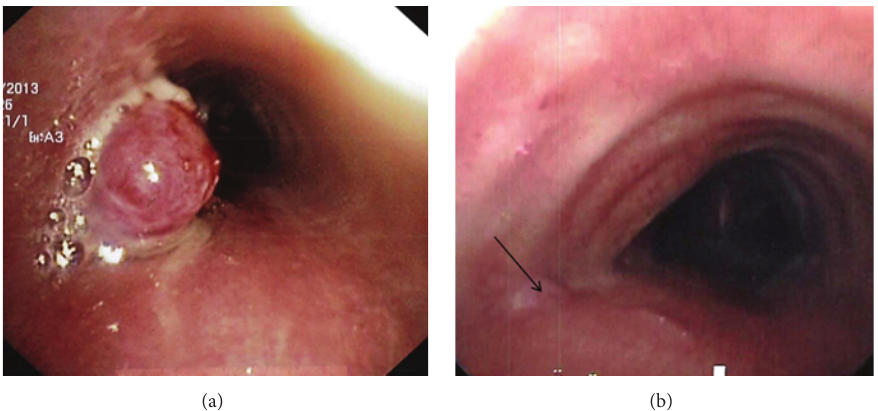
Figure 2: (a) Distinct cherry-like polyp consistent with hemangioma arising from the left lateral wall of the mid-trachea depicted on bronchoscopy. (b) Bronchoscopy performed two years later revealed a small scar induration with normal mucosa (arrow) overlaying it at the base of the previously resected hemangioma.